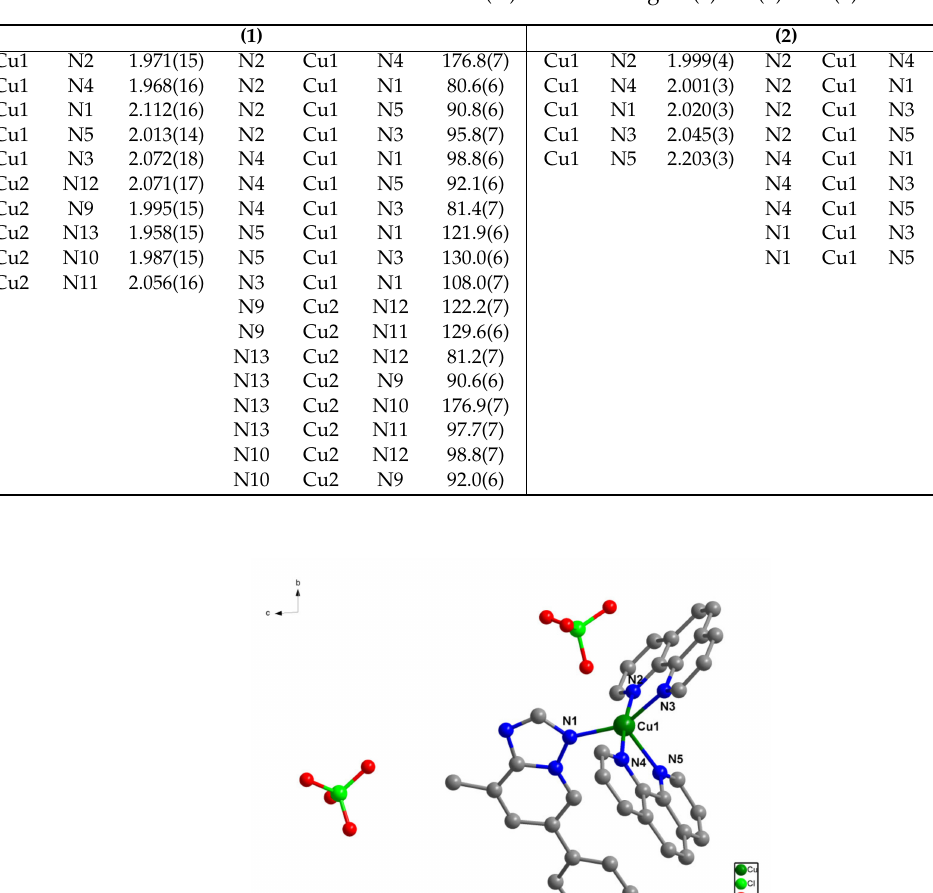
Table 2. Selected bond distances (Å) and bond angles ( ◦ ) for ( 1 ) and ( 2 ).